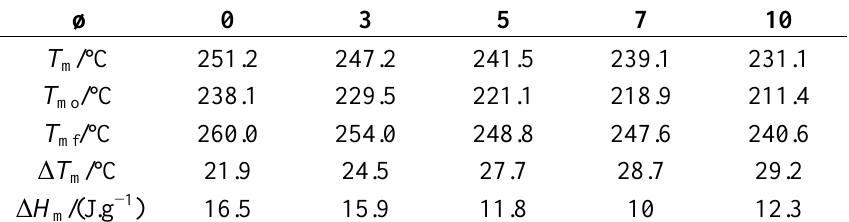
Table 3. Thermodynamic parameters of each